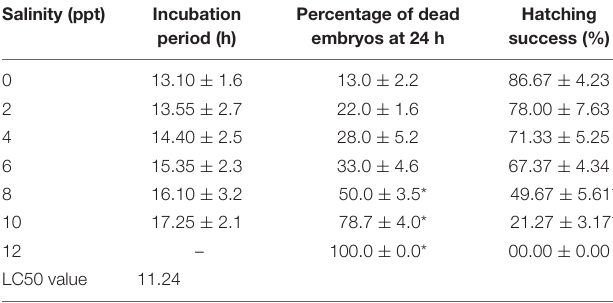
TABLE 1 | Effects of salinity on the incubation period and hatching success of embryos of striped catfish ( n = 300 embryos). Salinity (ppt) Incubation Percentage of dead period (h) embryos at 24